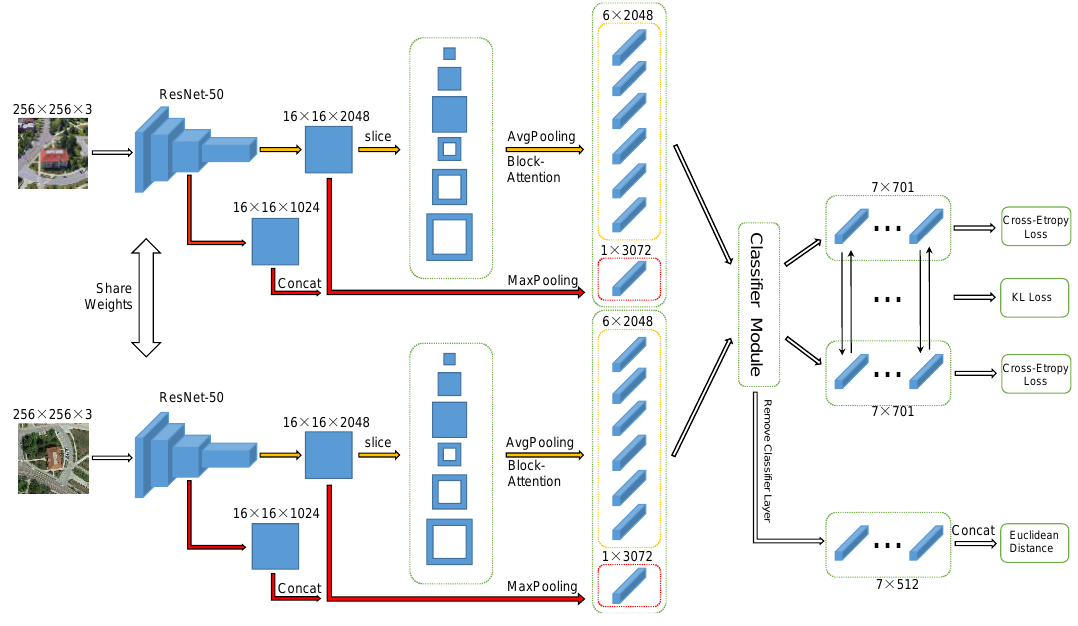
Figure 1. Framework of proposed MSBA.